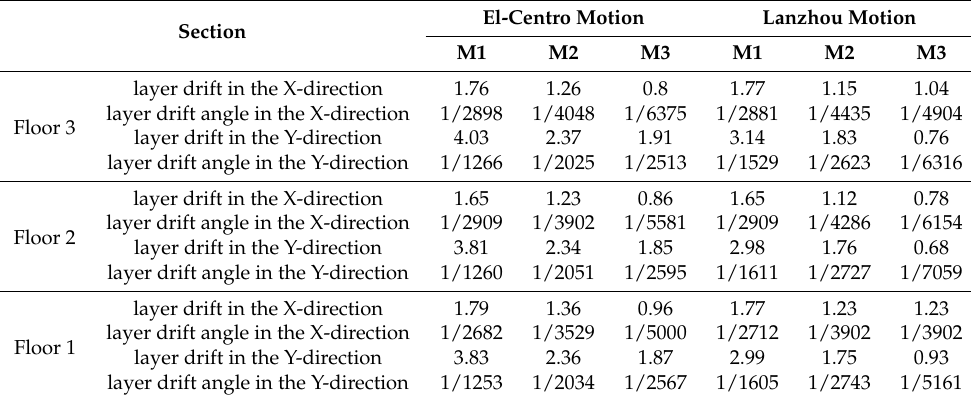
Table 7. Layer drifts (mm) and layer drift angles